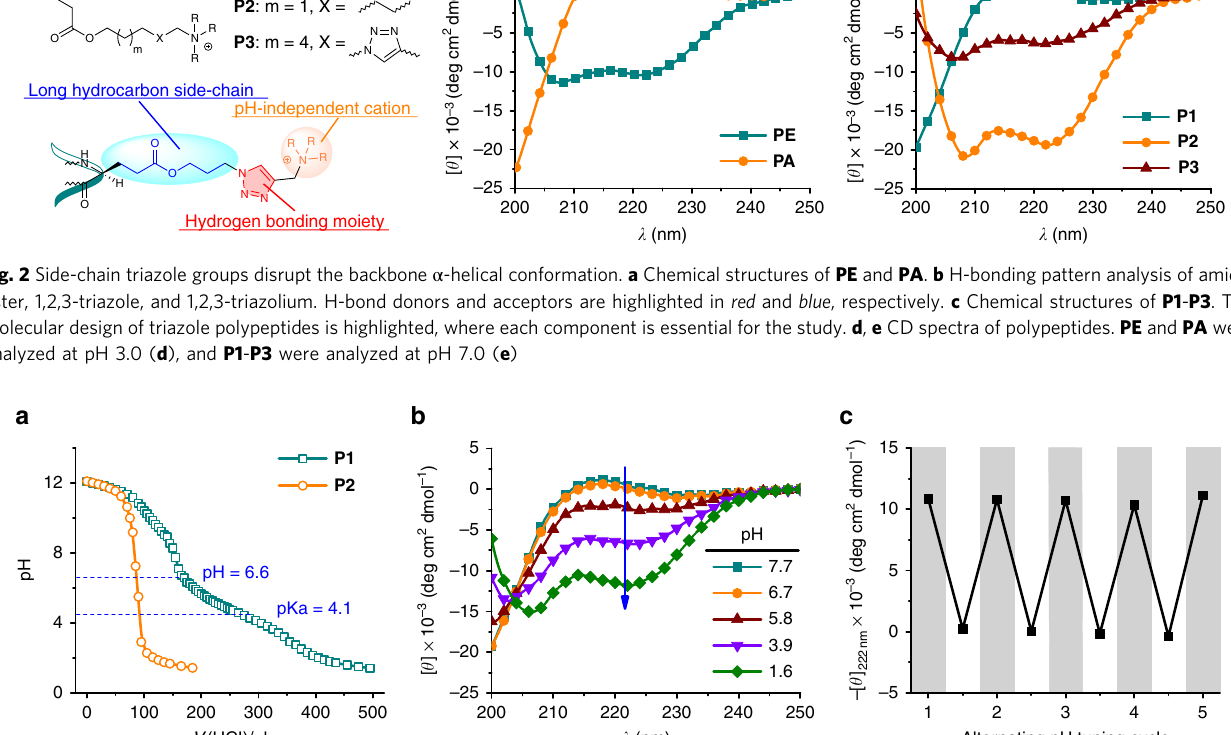
inhibits the ability of this group to participate as a H-bond acceptor. The resulting 1,2,3-triazolium cation, instead, possesses two weaker H-bond donors (UHB pattern, Fig. 2b) 30 . According